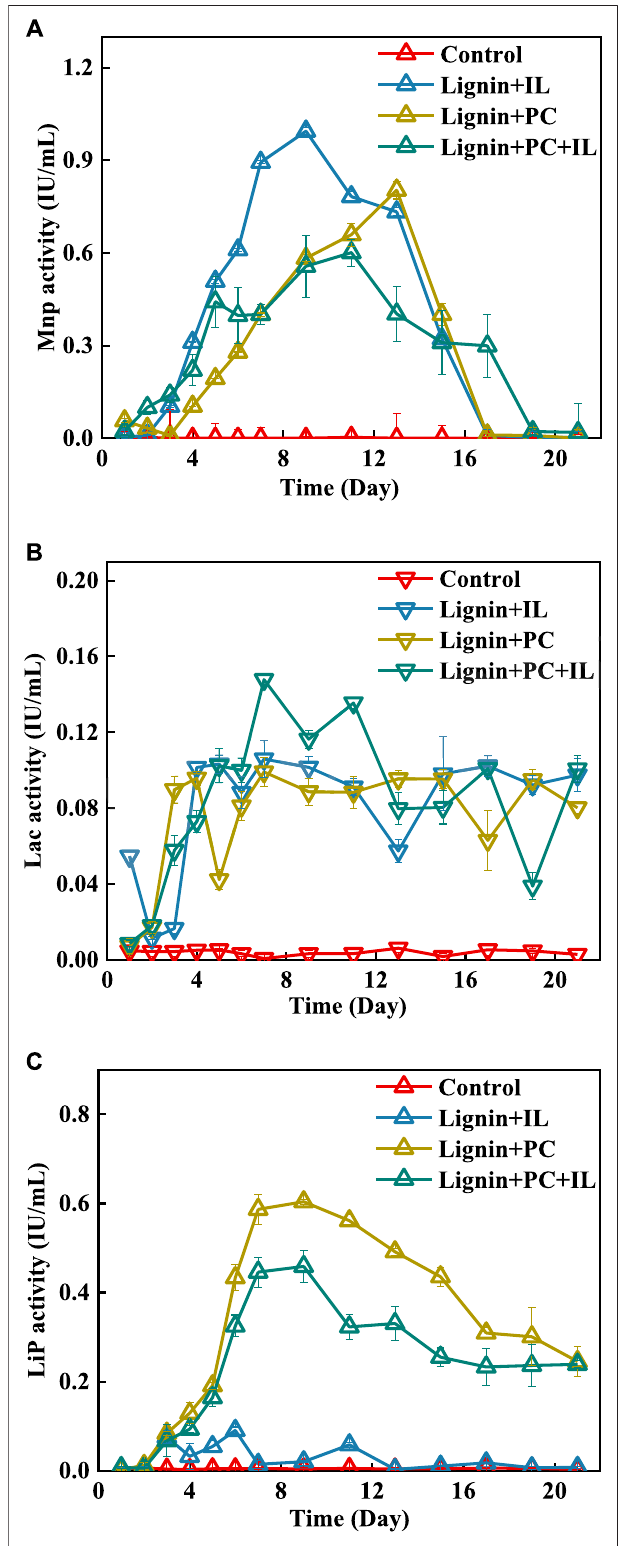
FIGURE 2 | LDEs during alkali lignin degradation for (A) MnP, (B) Lac, and (C)